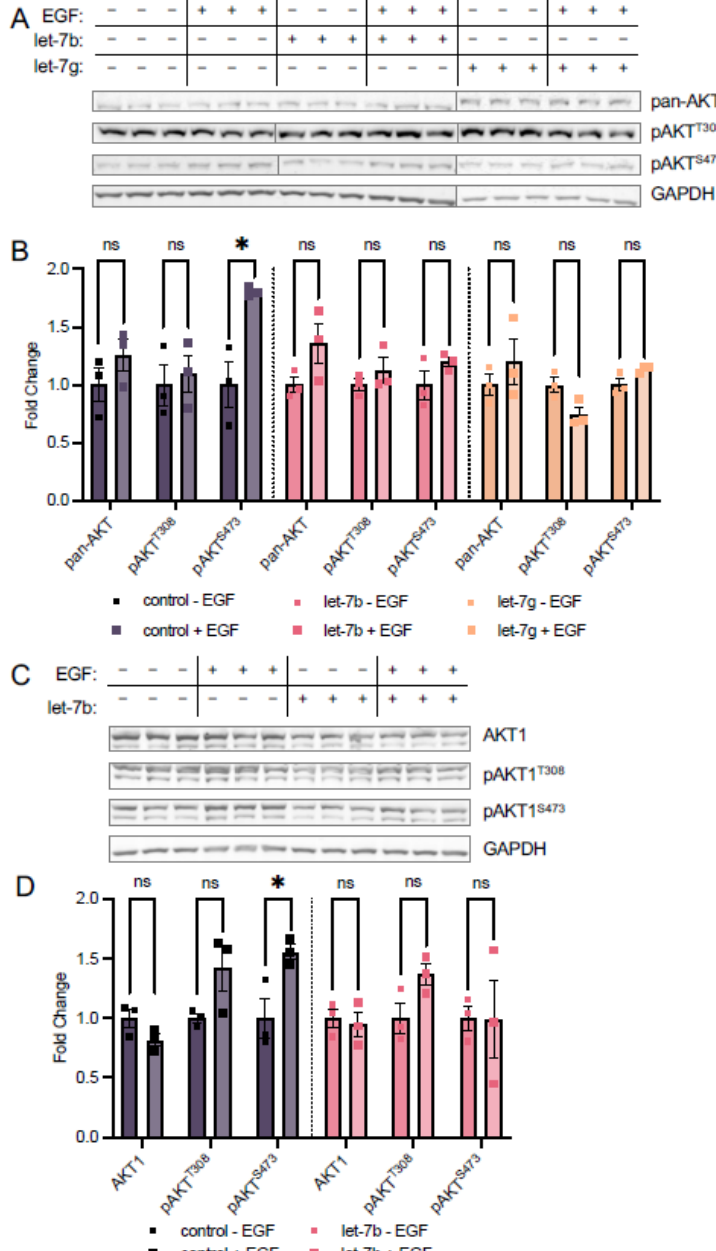
Figure 6. let-7b and let-7g regulate phosphorylation of AKT at Ser-473. ( A ) Western blots and ( B ) quantification of pan-AKT and pAKT protein levels in HEK 293T cells transfected with 60 fmol let-7b (pink), let-7g (orange), or no RNA control (grey) for 24 h and stimulated with epidermal growth factor (EGF, square symbols) or without (circle symbols) EGF for 15 min. ( C ) Western blots and ( D ) quantification of mCherry-AKT1 and mCherry-pAKT1 levels in HEK 293T cells co-transfected with 5 µ g mCherry-mAKT1 plasmid and 60 fmol let-7b (pink) or a control lacking RNA (grey) for 24 h and stimulated with (square symbols) or without (circle symbols) EGF for 15 min. The data include n = 3 biological replicates. Error bars show ± 1 SEM. Asterisks indicate significance (ns, not significant; * p <